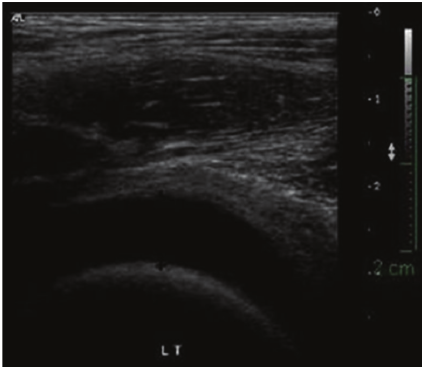
Figure 1: Ultrasound of patient’s left hip at the emergency room showing distention of the hip joint due to increased fluid level.